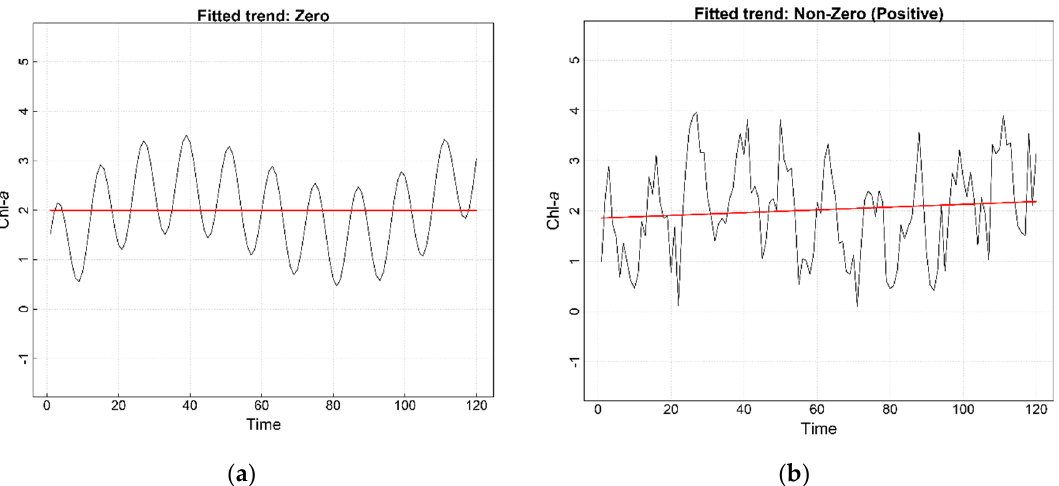
Figure 2. ( a ) Diagrammatic example of a monthly chlorophyll- a (chl- a ) time series of 10 years with seasonal and interannual variability but no trend. ( b ) adds random observational noise to this series which induces an apparent small non-zero positive trend, a negative trend would be just as likely with another sampling of random noise.